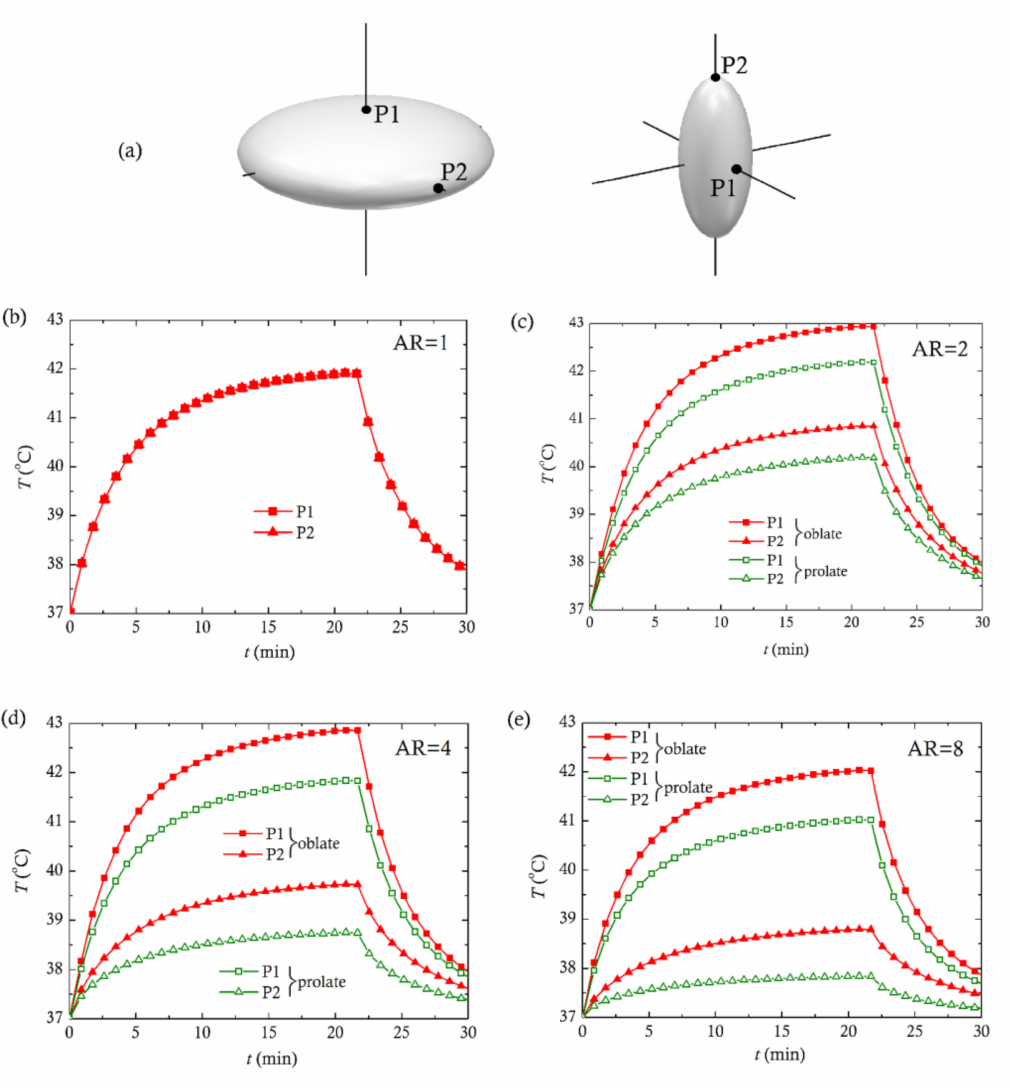
Figure 8. Treatment temperature on the tumor surface, at two tumor surface probe locations P1 and P2 shown in the scheme ( a ) for: ( b ) AR = 1, ( c ) AR = 2, ( d ) AR = 4 and ( e ) AR = 8. All ellipsoidal tumor shapes have the same